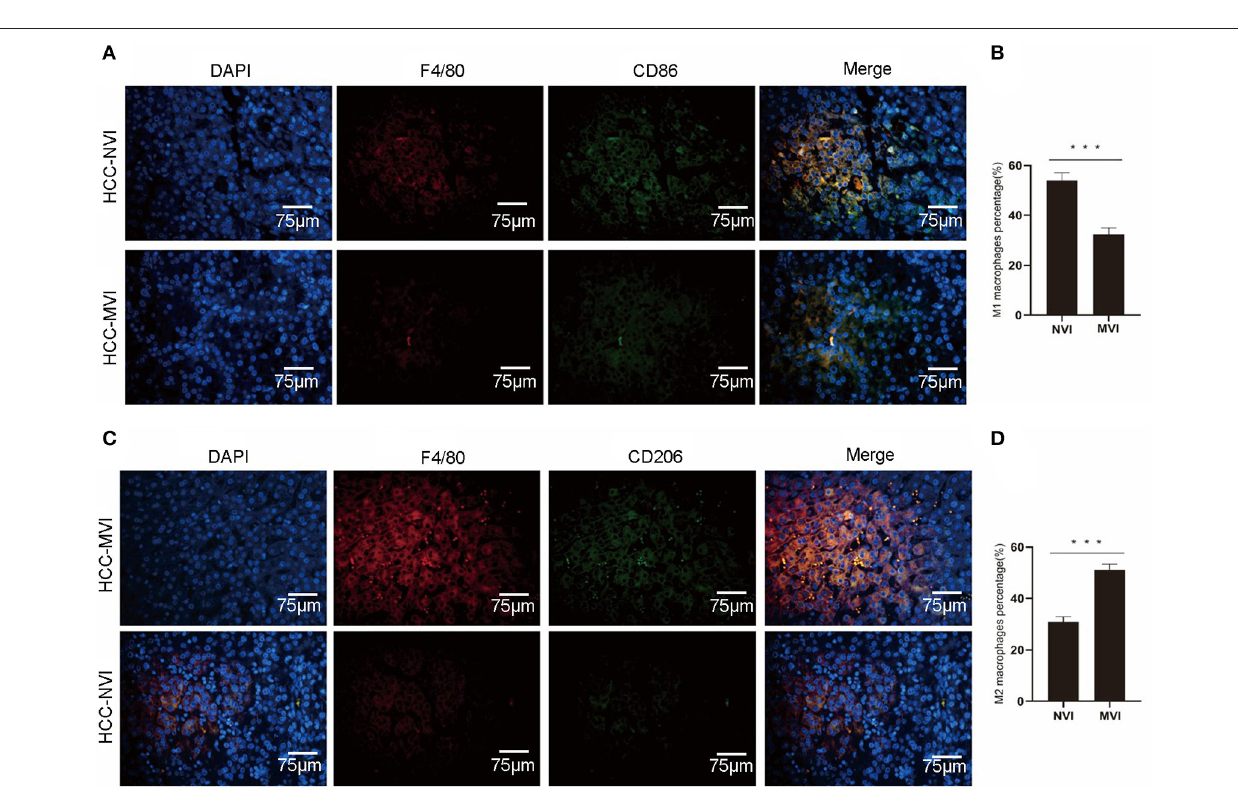
FIGURE 8 | Immunofluorescence profiles of HCC. Representative image (A) and calculation (B) of M1 TAM positive rate in the HCC-MVI and HCC-NVI groups (40 × magnification). Representative image (C) and calculation (D) of the M2-type TAM positive rate in the HCC-MVI and HCC-NVI groups (40 × magnification). Scale bar: 75 µ m, *** P < 0.001 by